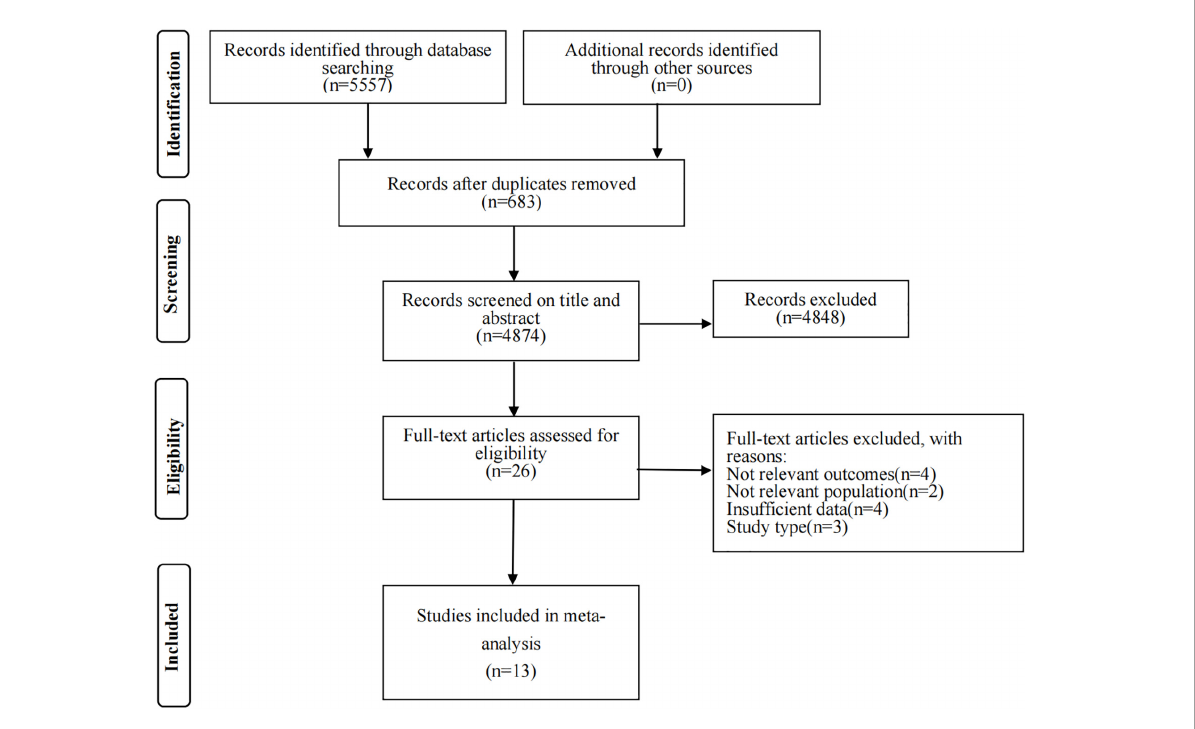
FIGURE1 The flow chart of literature